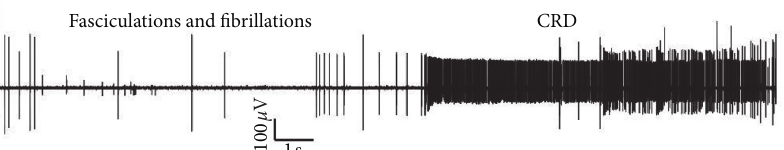
Figure 3: Needle electromyogram showing spontaneous activity in the right abductor pollicis brevis muscle with fasciculations, fibrillations, and complex repetitive discharge at 90–120